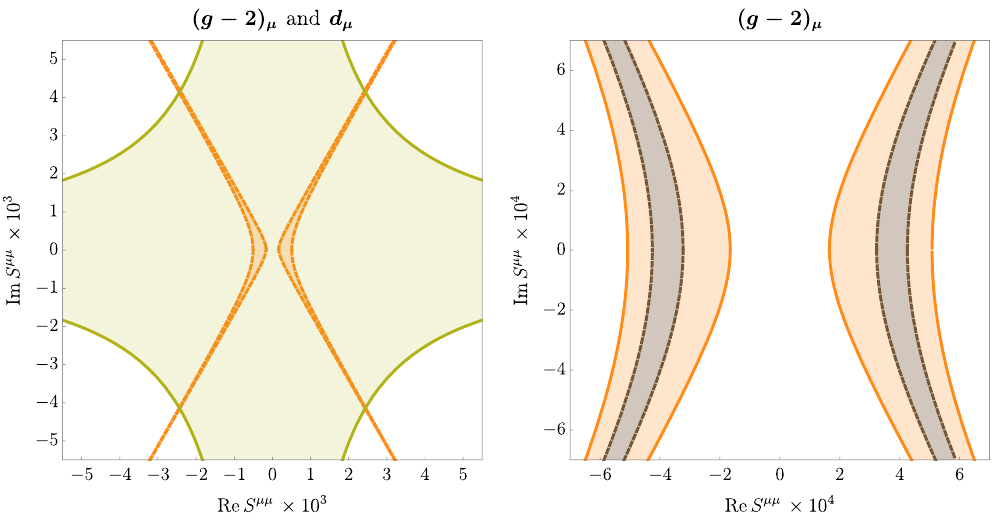
Figure 12 . Favored regions for the diagonal coupling S µµ , due to the muon anomalous magnetic and electric dipole moments. In the figure on the left it is seen that the bound from the muon EDM (yellow continuous curves) does not restrict too much the AMM of the muon (orange dashed curves). On the right figure, only the muon AMM is represented and within the light (dark) region, the current experimental deviation is explained at the 3 σ ( 1 σ )